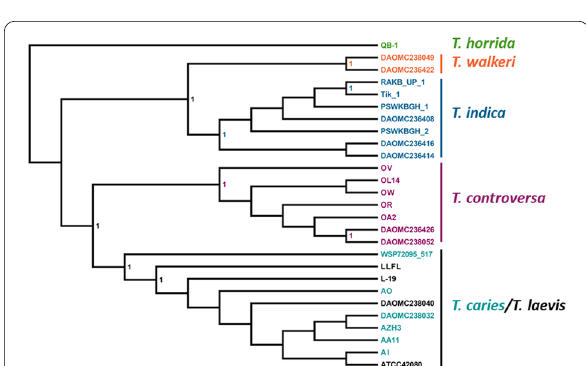
Fig. 3 Coalescence-based phylogenetic analysis on a set of 241 genes and 27 strains of six Tilletia species. Individual trees were obtained from approximately maximum likelihood analysis per locus and the coalescence inference was based on all the resulting trees using ASTRAL II. Each isolate is color coded based on species identification. Node support values are given as local posterior probabilities. Only supporting values above 0.95 are indicated at